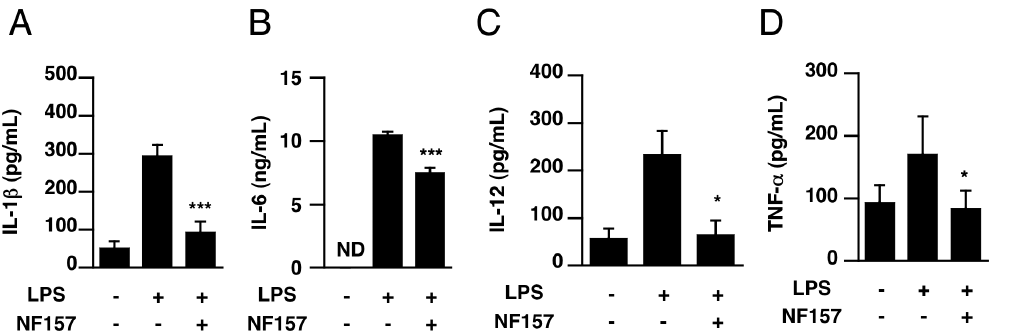
Figure 9. P2Y11 antagonist NF157 blocked the increase in peritoneal levels of cytokines in LPS-treated mice. (A – D ) Male C57BL/6 mice were injected intraperitoneally with LPS (400 m g/head i.p.). NF157 (100 m L of 500 m M) was administered i.p. at 2 h before LPS was injected. Peritoneal lavage fluid was collected 6 h after LPS injection for measurement of IL-1ß, IL-6, IL-12 and TNF-alpha. Each value represents the mean 6 SE (n=4). Significant differences between a test group and control group (LPS alone) are indicated by *(p , 0.05) and ***(p , 0.001), respectively.